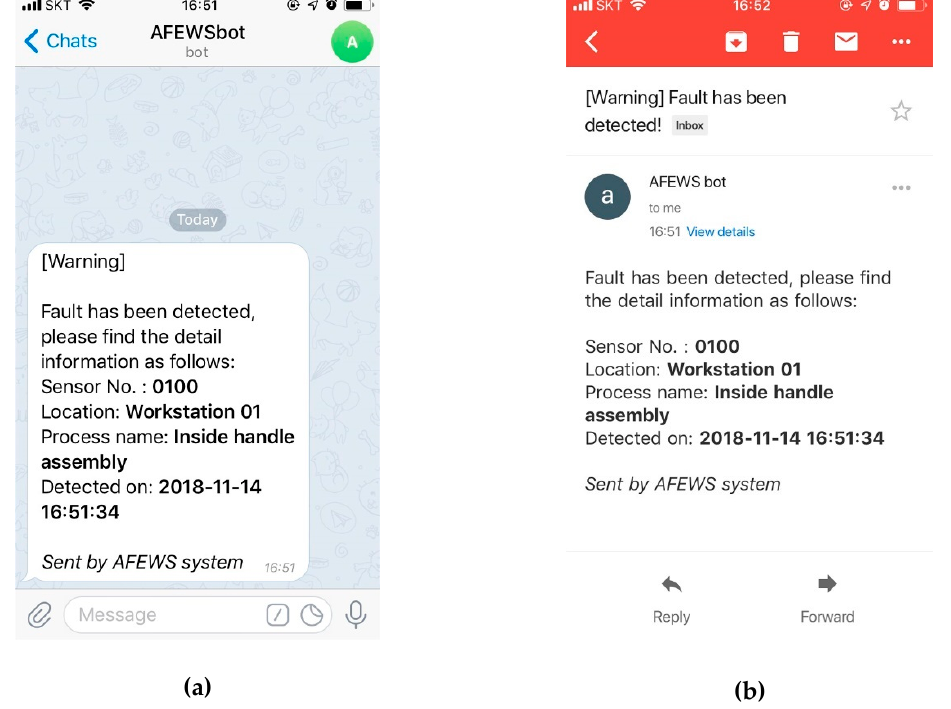
Figure 8. Warning message from AFEWS to registered contact via (a) Telegram messenger and (b) email.